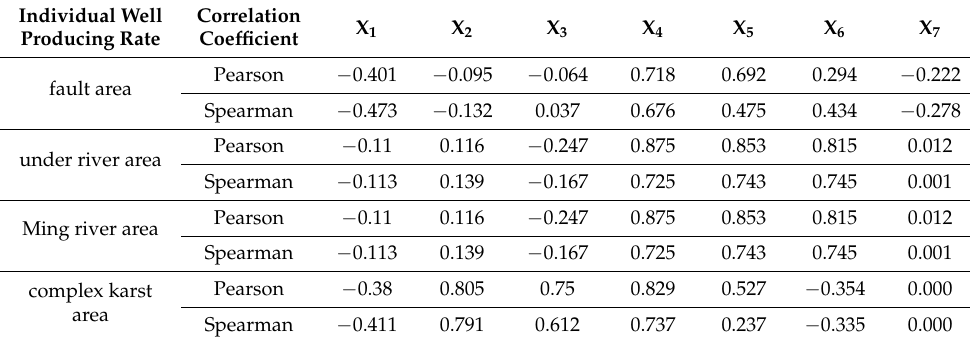
Table 1. Correlation analysis table of seismic attributes and dynamic data.